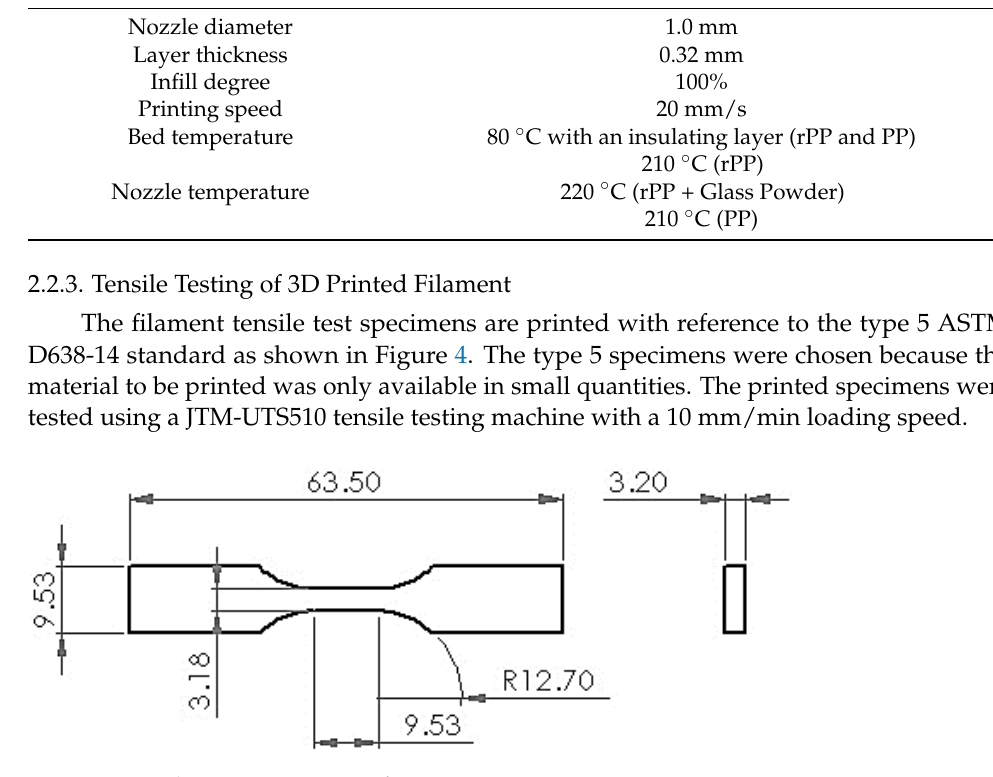
Figure 4. Tensile test specimen size for type 5 ASTM D638-14.